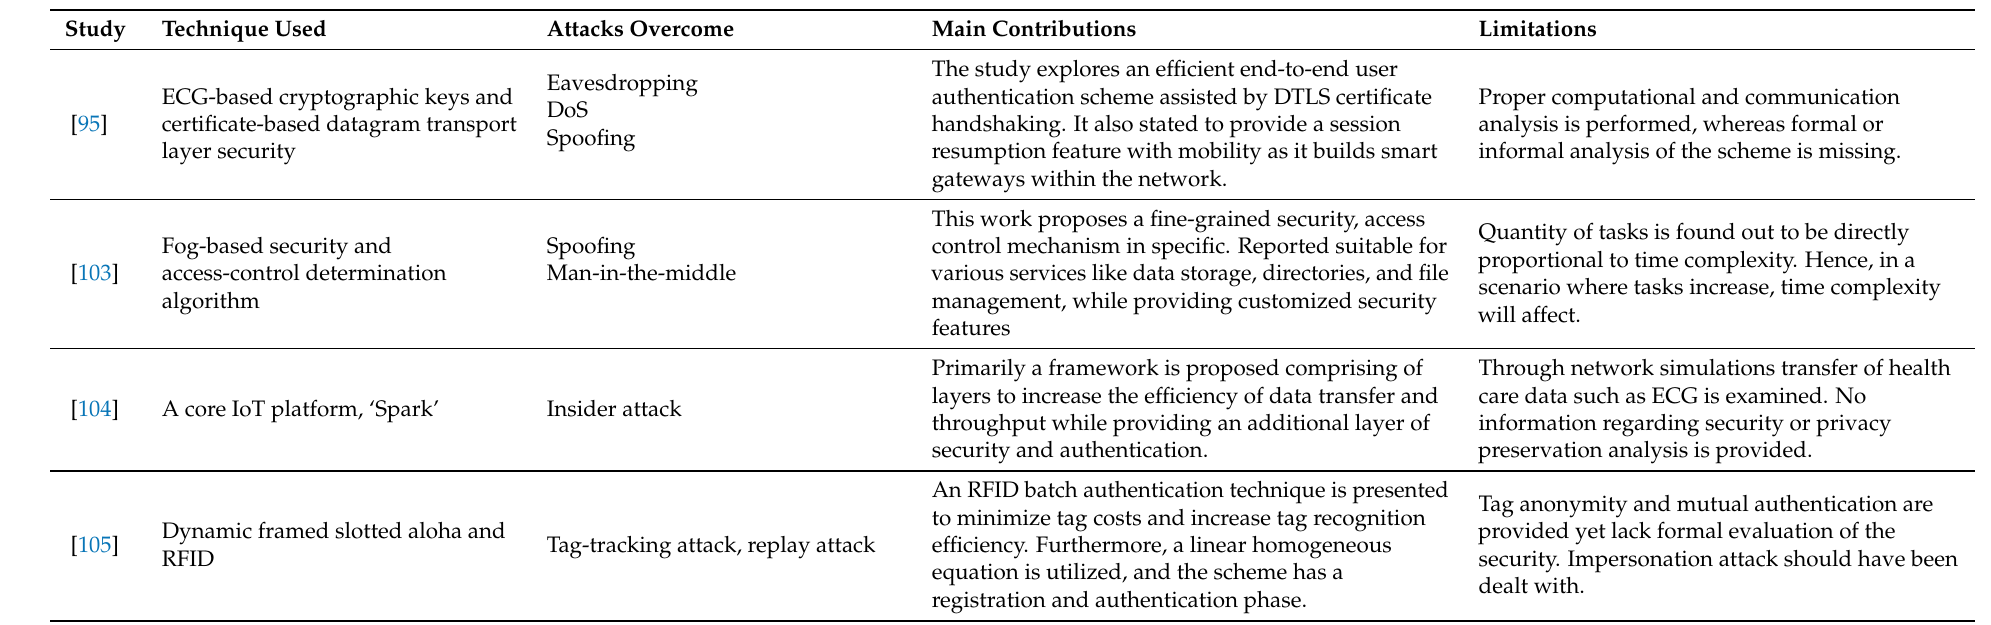
Table 3. Fog-based authentication techniques in IoT-enabled healthcare